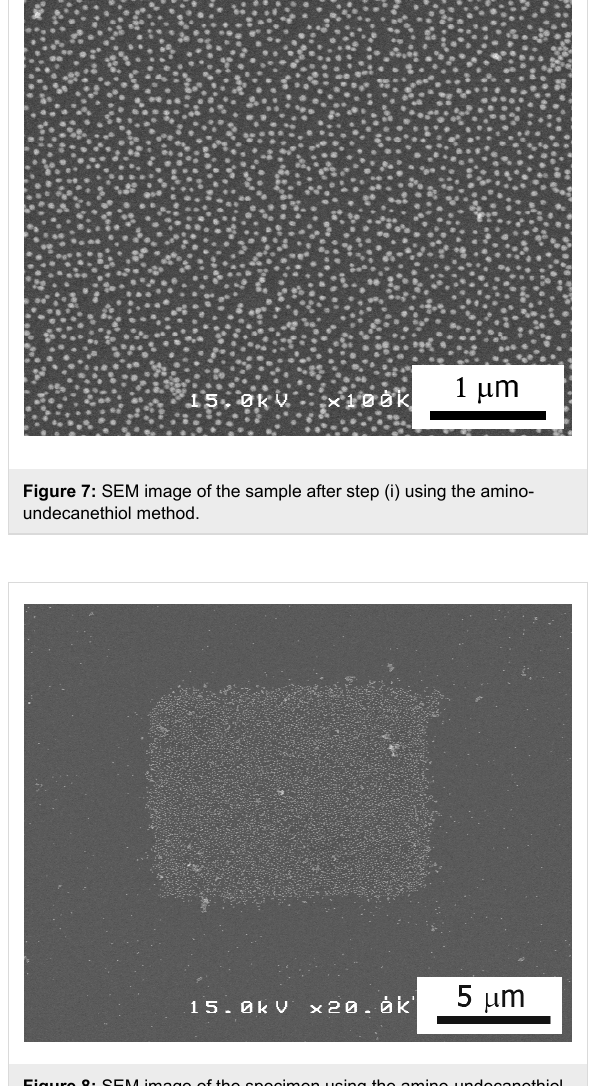
Figure 8: SEM image of the specimen using the amino-undecanethiol method after step (iii), illustrating that the nanoparticles remained in the rectangular area of electron